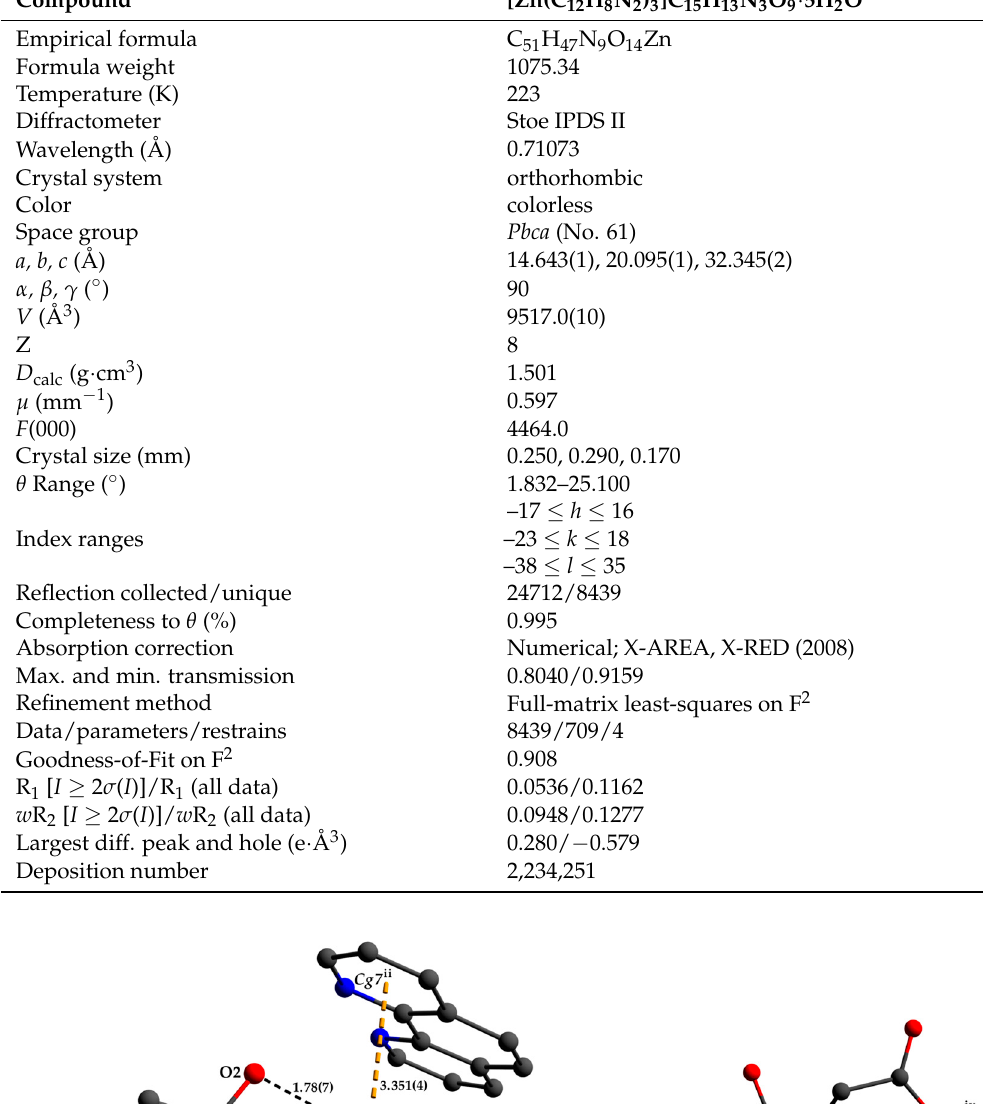
Table 1. Crystal data and structural refinement parameters of the [Zn(C 12 H 8 N 2 ) 3 ]C 15 H 13 N 3 O 9 · 5H 2 O.